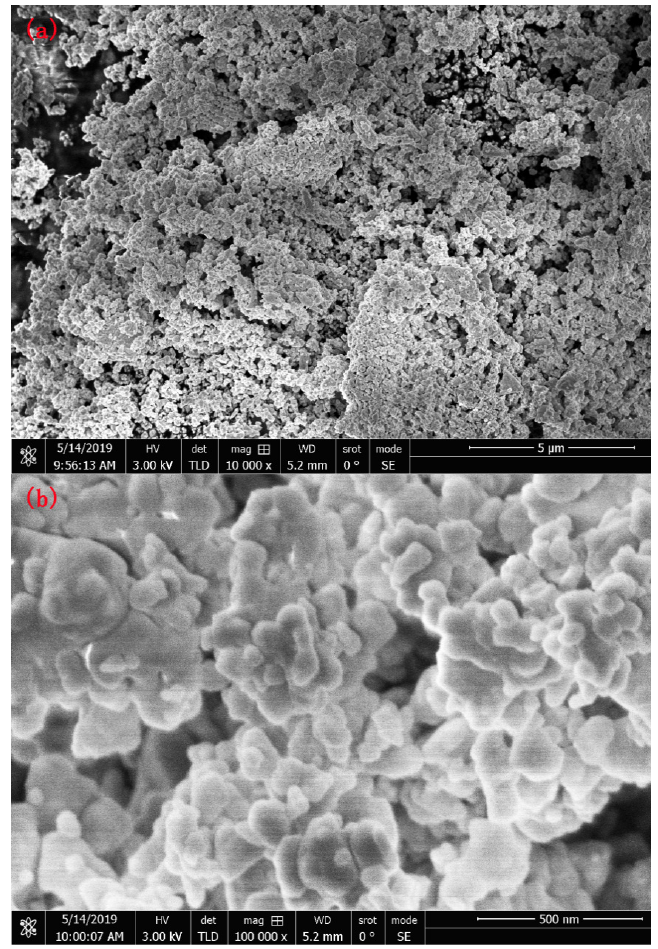
Figure 2. Scanning electron microscope (SEM) images for ZnGa 2 O 4 . ( a ) the SEM image in large-scale; ( b ) the SEM image in nano-scale.